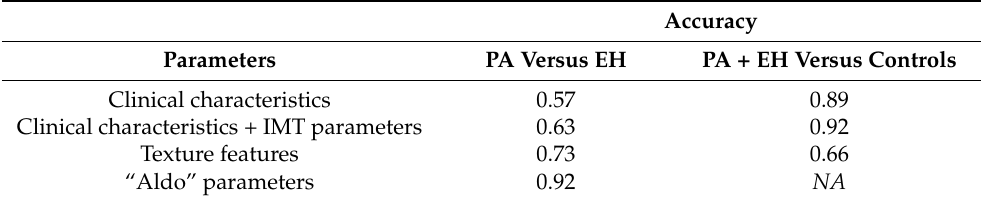
Table 6. Per-patient classification accuracy evaluated by leave-one-out for different feature subsets and the two classification tasks.